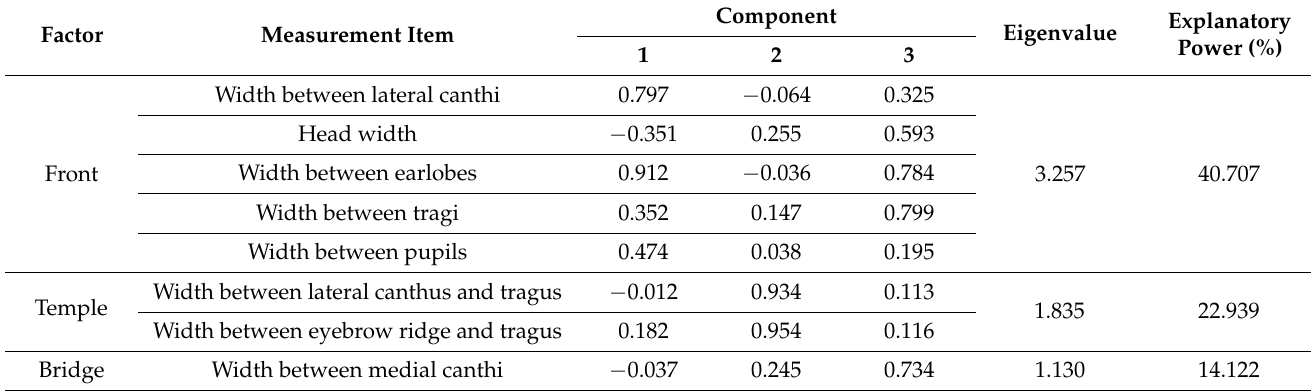
Table 2. Results of factor analysis of the human body measurement items related to the glass frame.